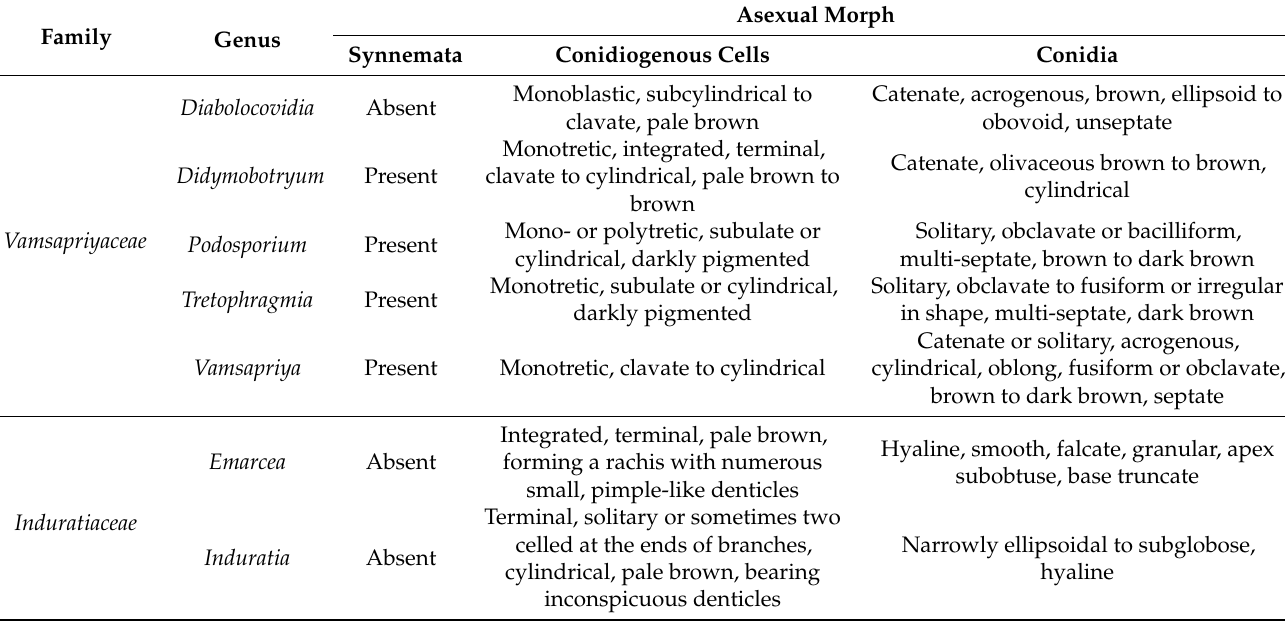
Table 5. Asexual morph comparison of the genera in Clypeosphaeriaceae , Induratiaceae and Vamsapriyaceae .